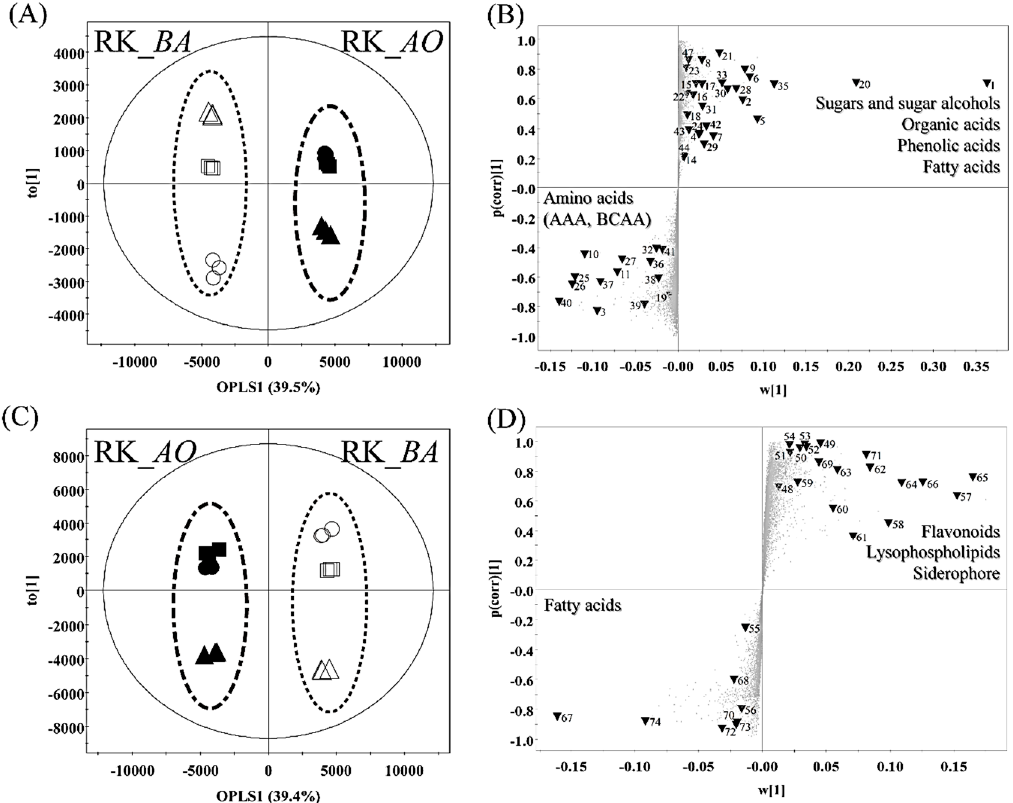
Figure 2. The OPLS-DA score plot ( A , C ) and loading S-plot ( B , D ) for rice koji fermented with A. oryzae (RK_ AO ) or B. amyloliquefaciens (RK_ BA ) obtained by GC-TOF-MS ( A , B ), and UHPLC-LTQ-IT-MS/MS ( C , D ). Highlighted metabolites ( İ ) in the S-plot indicate statistically significant differences between RK_ AO and RK_ BO (VIP > 1.0 and p < 0.05 in OPLS-DA). Each labeled peak number indicates a metabolite in Tables S1 and S2. The stated super-classes contain the identified metabolites (AAA, aromatic amino acid; BCAA, branched chain amino